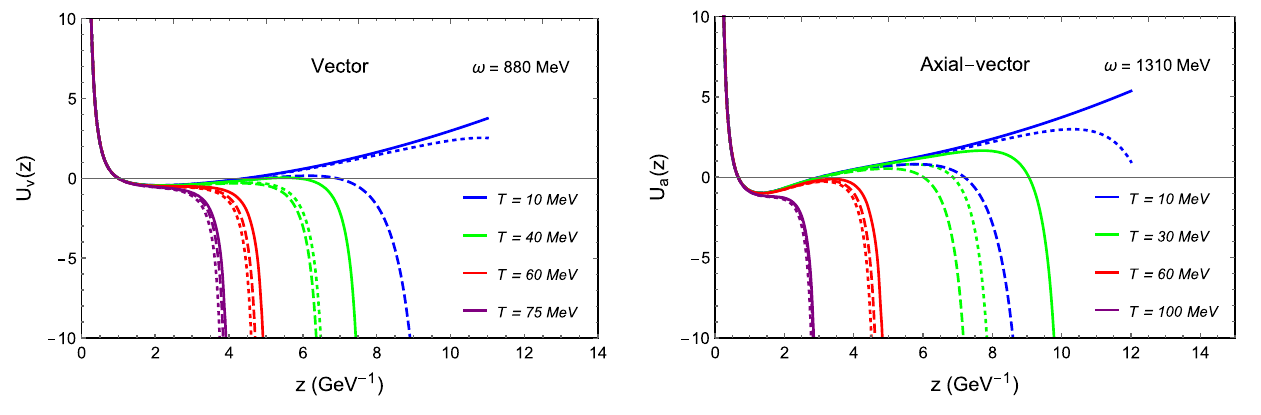
Fig. 7 Thepotentialfunctions U v ( z ) and U a ( z ) forthegroundstatesof the vector and axial-vector mesons at four different temperatures. The solid curves denote the case of μ = 0 and B = 0, the dashed curves